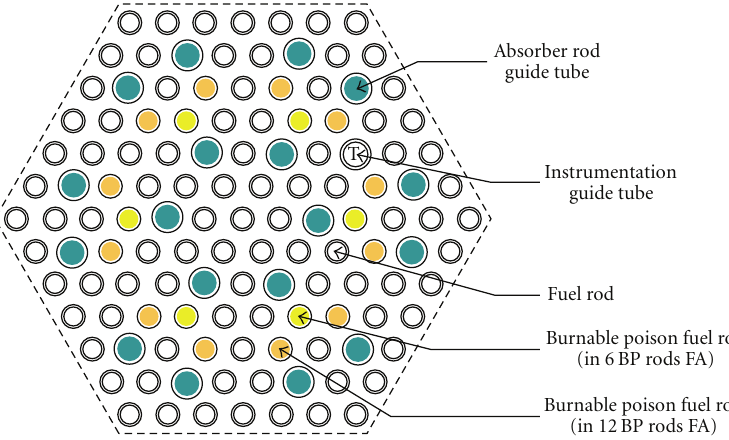
Figure 2: Fuel assembly diagram. Fuel rods and guide tubes distribution.